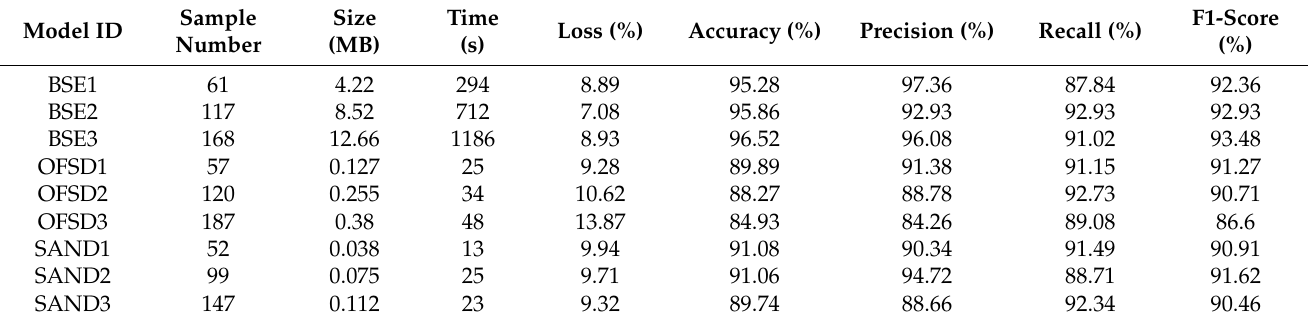
Table 2. Resultant time and performance for nine net models under an epoch of 30.